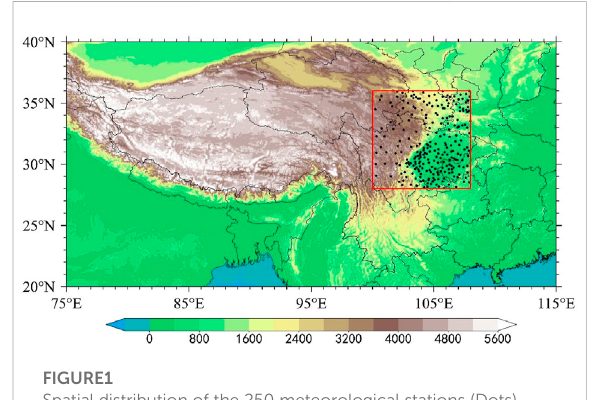
FIGURE1 Spatial distribution of the 250 meteorological stations (Dots) in western China and the geographical features (Unit: